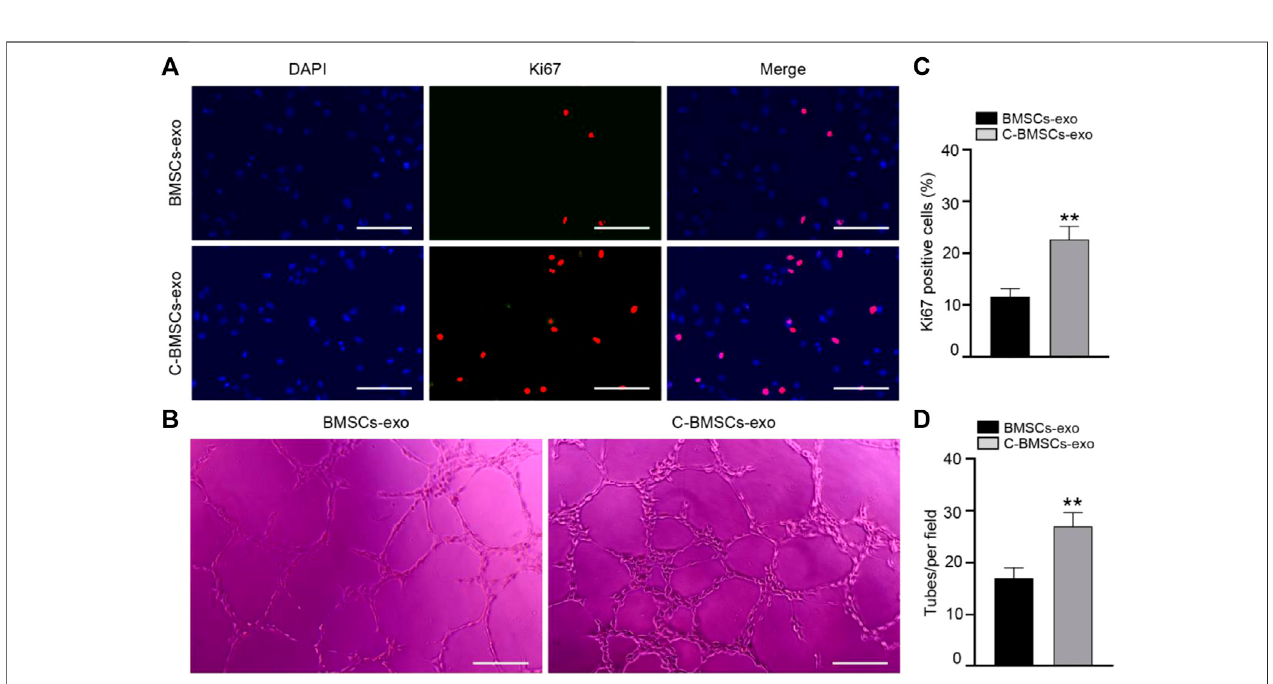
FIGURE 4 | C-BMSC-exo treatment alters HUVEC proliferation and angiogenic activity. (A) Ki67 staining was used to assess HUVEC proliferation in the indicated groups (Scale bar: 50 μ m). (B) Representative images of HUVEC tube formation following culture on Matrigel for 12 h in the presence of C-BMSC-exo or BMSC-exo treatments. (C) Numbers of Ki67-positive cells were quanti fi ed ( n = 3, biological replicates). (D) Numbers of tubes per fi eld of view were quanti fi ed, indicating that C-BMSC-exo treatment enhanced tube formation (Scale bar:200 μ m) ( n = 3, biological replicates). Samples were analyzed in triplicate. * p < 0.05, ** p < 0.01.